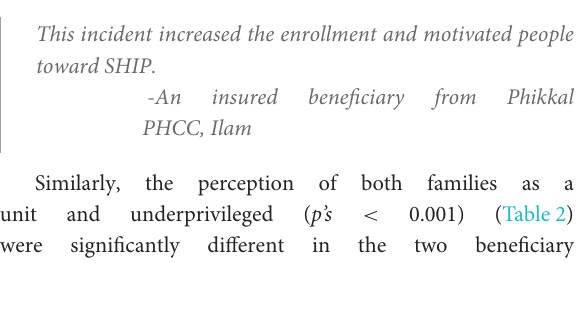
mixed findings were revealed during the interviews. Family as a unit is very supportive in healthcare; however, it can be a problem for a joint family with more than ten